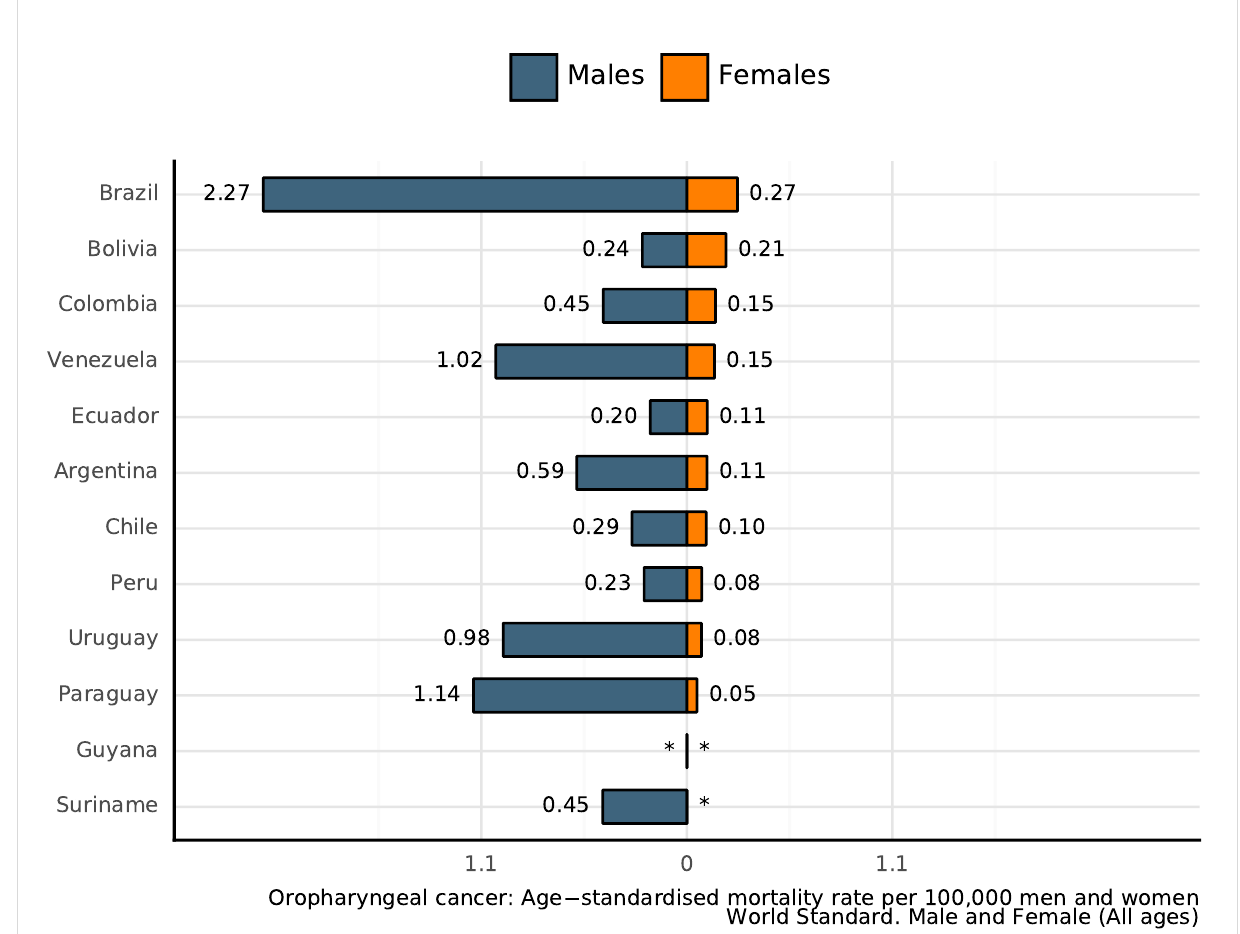
Oropharyngeal cancer: Age standardised mortality rate per 100,000 men and women World Standard. Male and Female (All